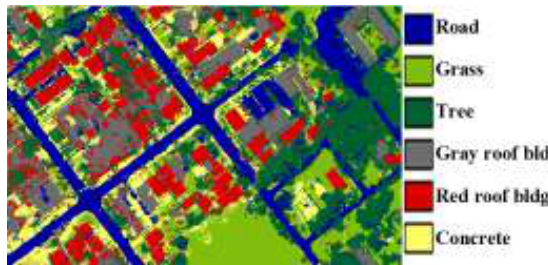
Figure 5. Results obtained for the RGB+DSMnThr+IS